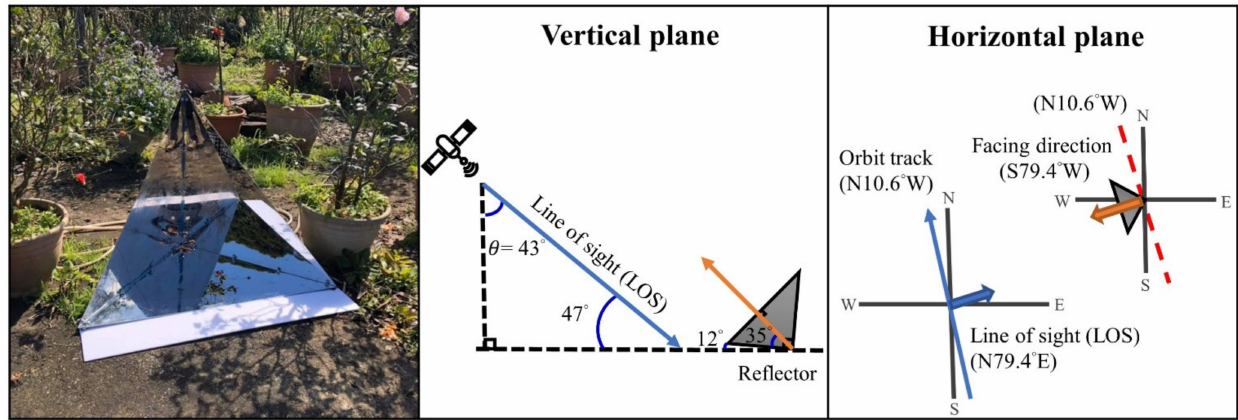
Figure 2. Geometry of the corner reflector designed for the ascending orbital geometry of the Sentinel-1 satellite, which was set up at the upper part of the Huafan University campus. The elevation of the corner reflector is 12 degrees and faces S79.4 ◦ W, which can effectively reflect the signal from the SAR sensor with a maximum